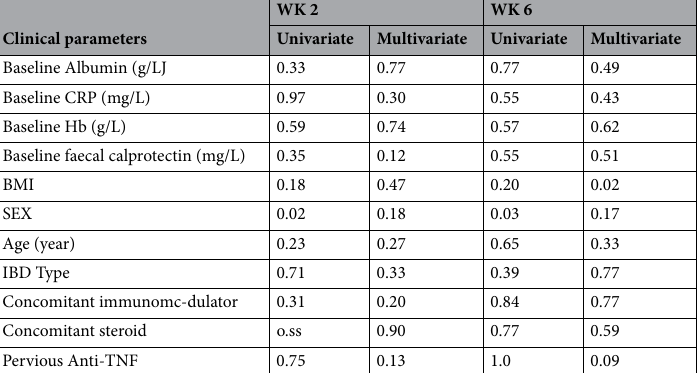
Table 3. Univariate and Multivariate Analysis of clinical parameters associated with week 2 and week 6 Vedolizumab trough levels. CRP C-reactive proteins, HB Haemoglobin, Anti-TNF Anti-tumour necrosis factor.